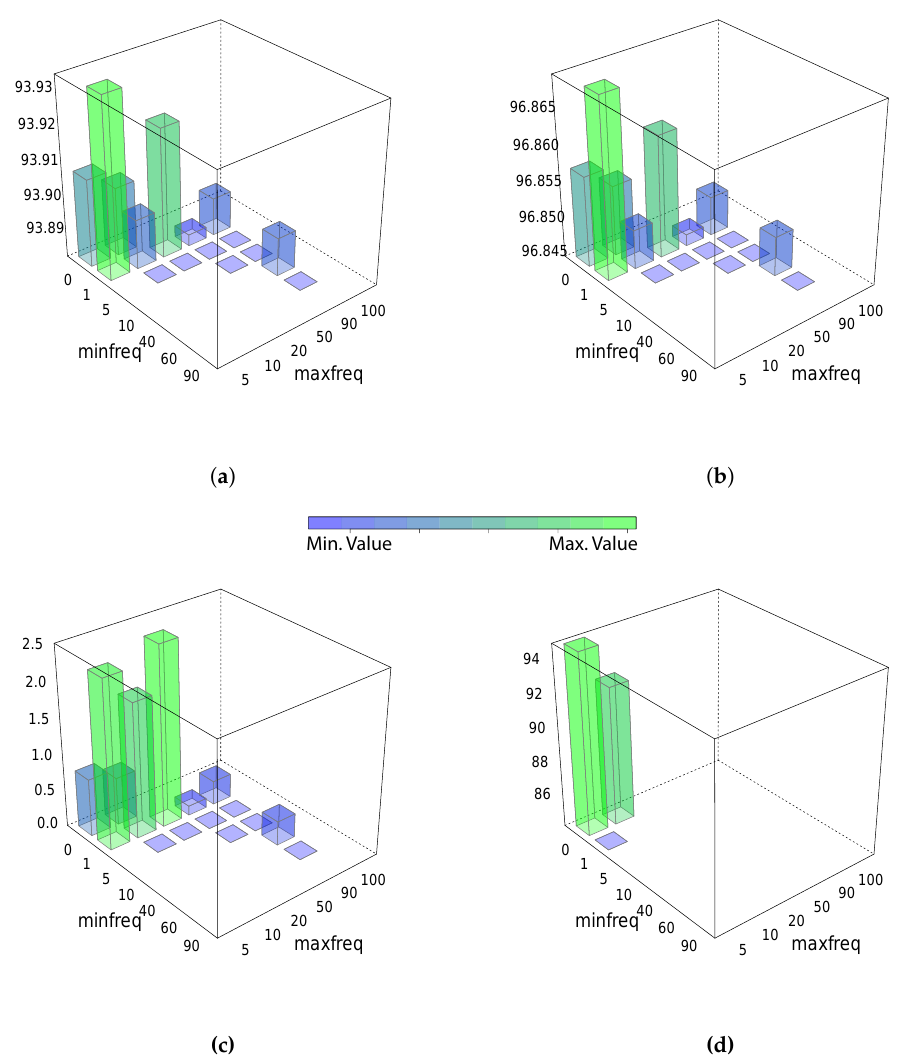
Figure 9. Summary of the results for the generator failures using a random forest model. The vertical axis indicates the minimal frequency % of a word in the training dataset in order to be selected by the model. The horizontal axis indicates the maximum frequency %. Each of the panels show a different metric for the same experiment. ( a ) shows the accuracy %, ( b ) the F-score in %, ( c ) the kappa in % and ( d ) indicates the AUC. Empty blocks (ranges) are values that cannot be calculated are from a prediction with a unique class